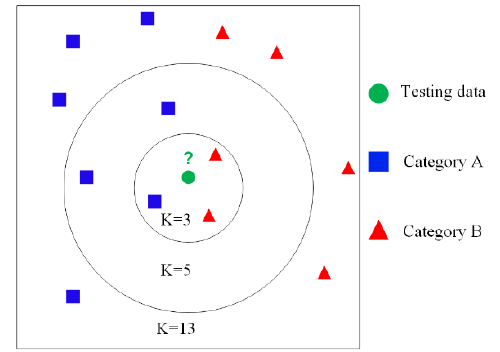
Figure 1. The k-nearest neighbor (KNN) schematic diagram.